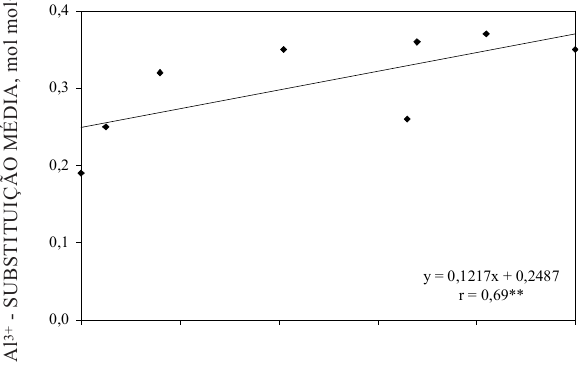
Figura 4. Correlações entre a razão Gb/(Gb + Ct) das amostras goethíticas latossólicas e a estimativa da substituição por Al 3+ na goethita em mol mol -1 , obtida por DRX (a); a proporção de Fe - relativo a goethitas de alta e muito d 20 alta estabilidade ( ) e a proporção de Fe relativo a goethitas de baixa e média estabilidade ( ) (b). * e ** coeficiente da equação significativo a 1 e 5 %,